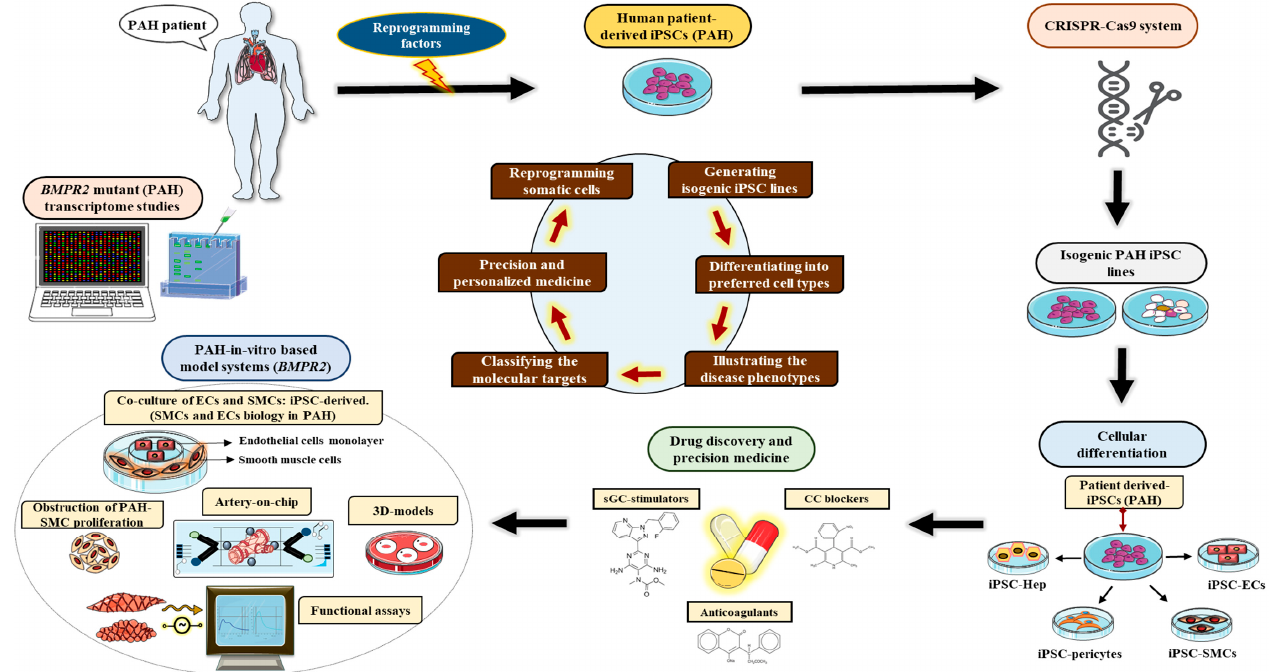
Figure 6. Human induced pluripotent stem cell (iPSC) utility for disease modeling systems. Patient ‐ derived iPSCs, harboring disease ‐ related mutations (i.e., PAH: BMPR2), can be “corrected” into control iPSCs by means of the CRISPR ‐ Cas9 gene editing strategy to produce isogenic cells/lines. To replicate the PAH phenotype “in a dish”, the patient ‐ derived iPSCs can be further differentiated into endothelial cells (ECs), smooth muscle cells (SMCs), hepatocytes (Hep), pericytes, and other related cell types. These specific differentiated cell types are then used with the 3D models described in the figure to study the underlying molecular and functional mechanisms that are responsible for specific cellular phenotypes. Such results can eventually pave the way for drug screening (soluble guanylyl cyclase: